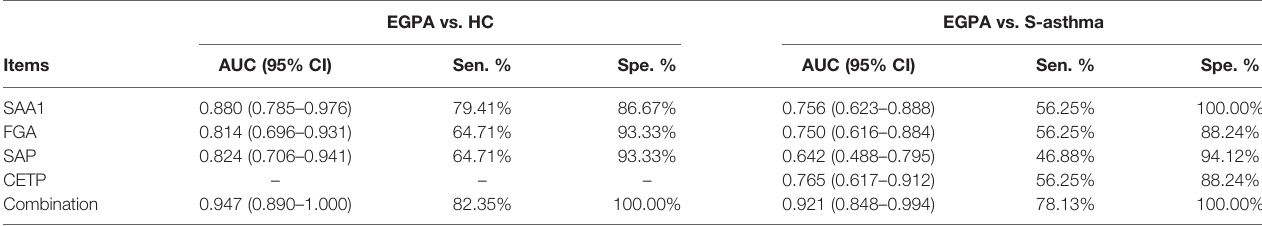
TABLE 2 | Diagnostic value of candidate biomarkers for distinguishing EGPA from healthy control and severe-asthma groups. EGPA vs.